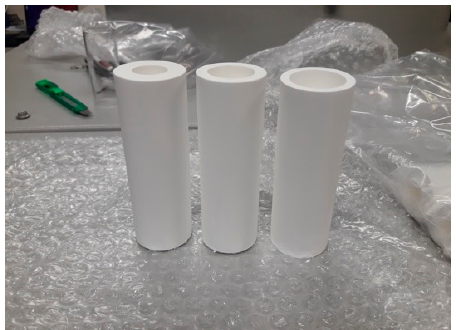
Figure 6. Boron nitride tubes with φ int = 16 mm, 19 mm and 22 mm.